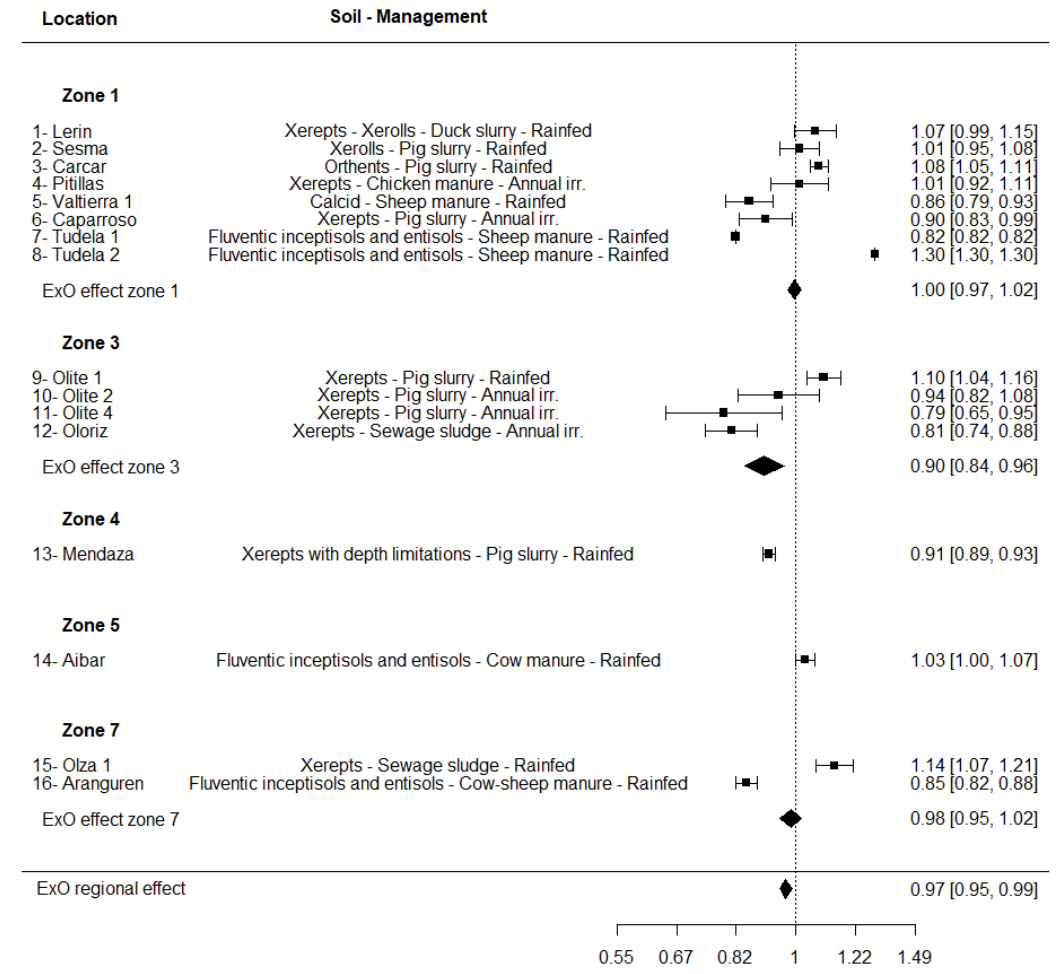
Figure 8. Response ratio (RR) of BD (0–30 cm) for the adaptive management strategy of exogenous sources of organic C addition (ExO). Zones correspond to those in Figure 1. The effect was considered significant when the 95% confidence interval (CI) of the RR did not overlap one ( α = 0.05). Soil and management column includes information about principal soil group, organic source applied and irrigation regime in each group.